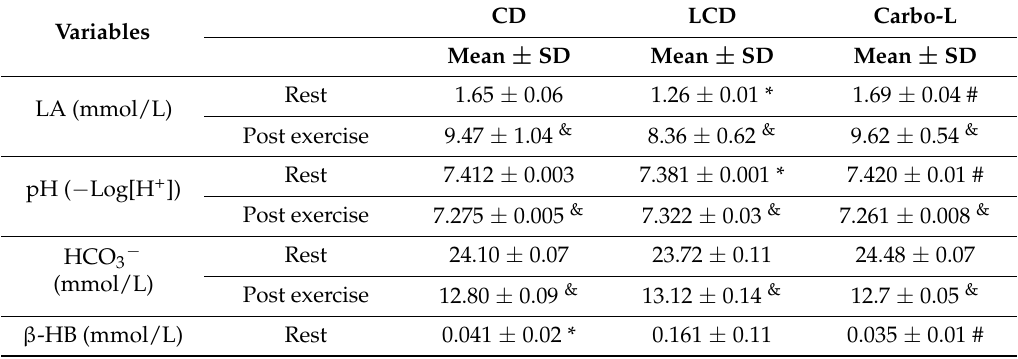
Table 4. The differences in the concentration of blood plasma lactate and acid-base variables, as well as the resting concentration of β -HB after particular dietary interventions in basketball